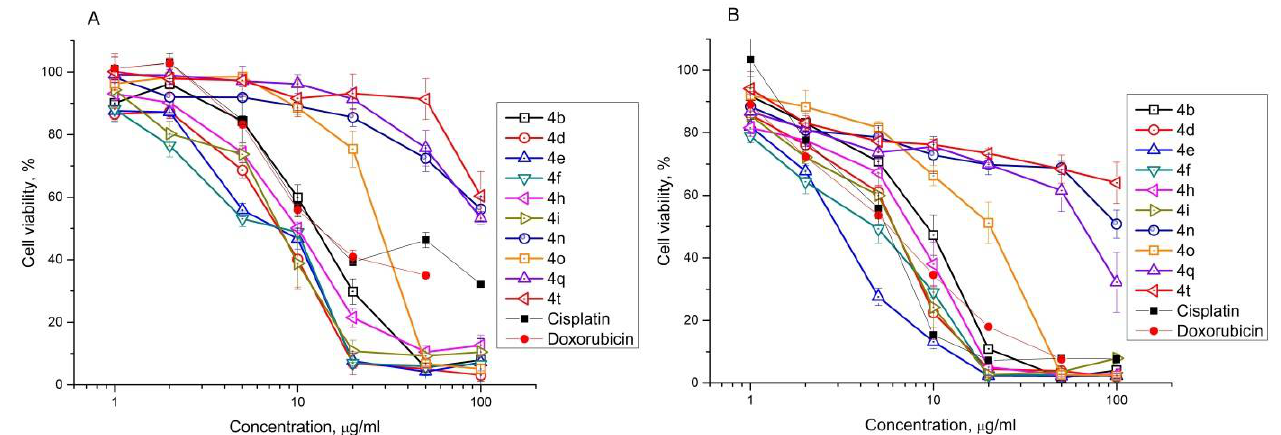
Figure 3. Cytotoxicity of selected 3-azaspiro[bicyclo[3.1.0]hexane-2,5′-pyrimidines] 4 against CT26 cell line for 24 h ( A ) and 72 h ( B ).